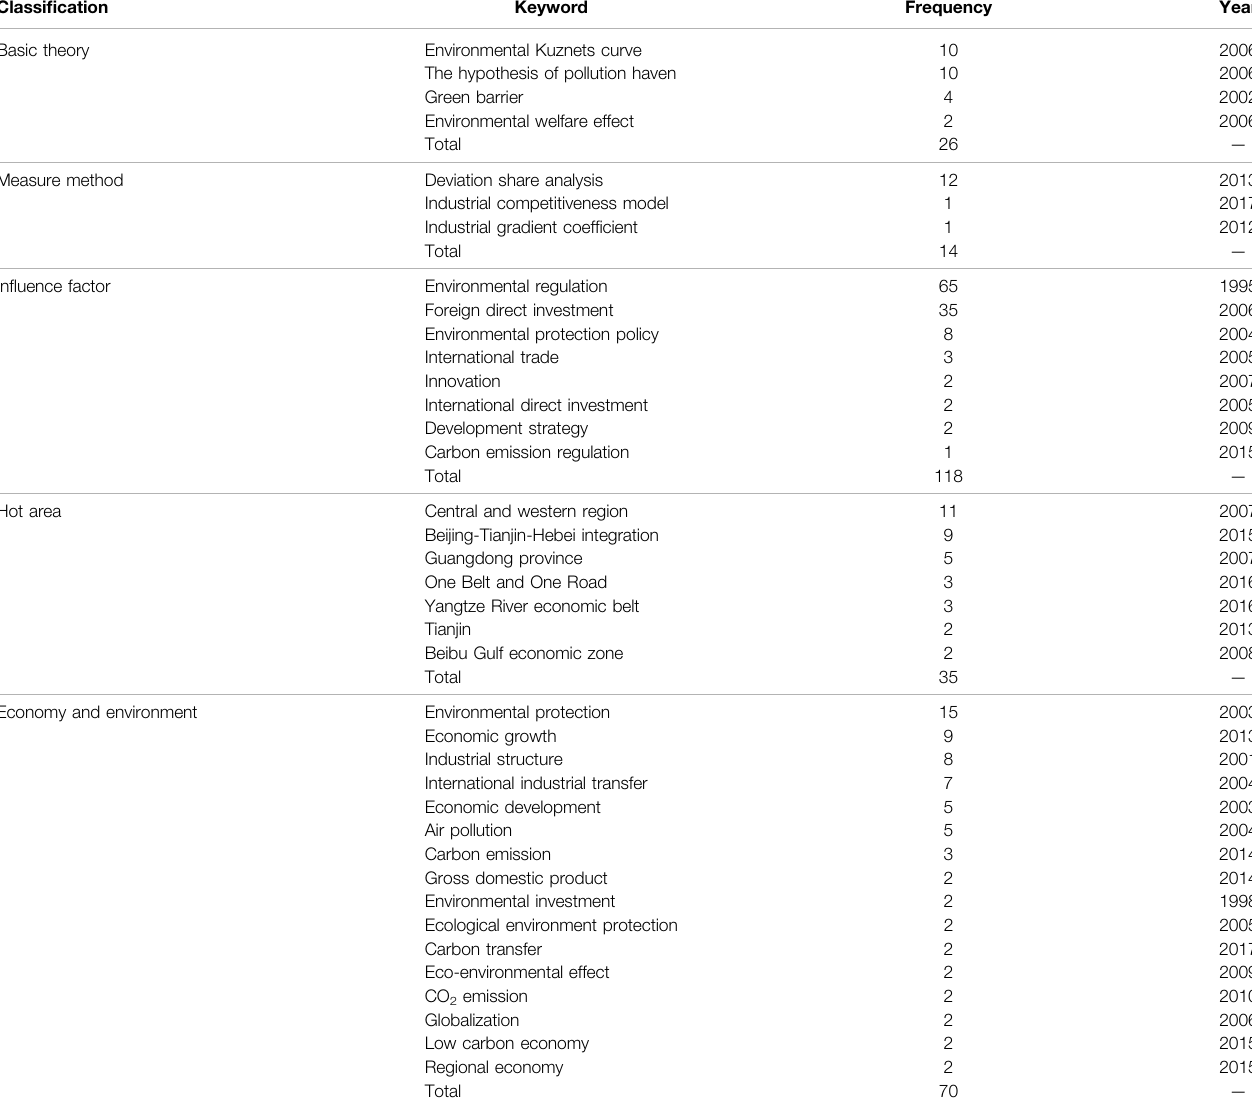
TABLE 1 | The ranking of the frequency of keywords in the fi eld of pollution-intensive industry transfer. Classi fi cation